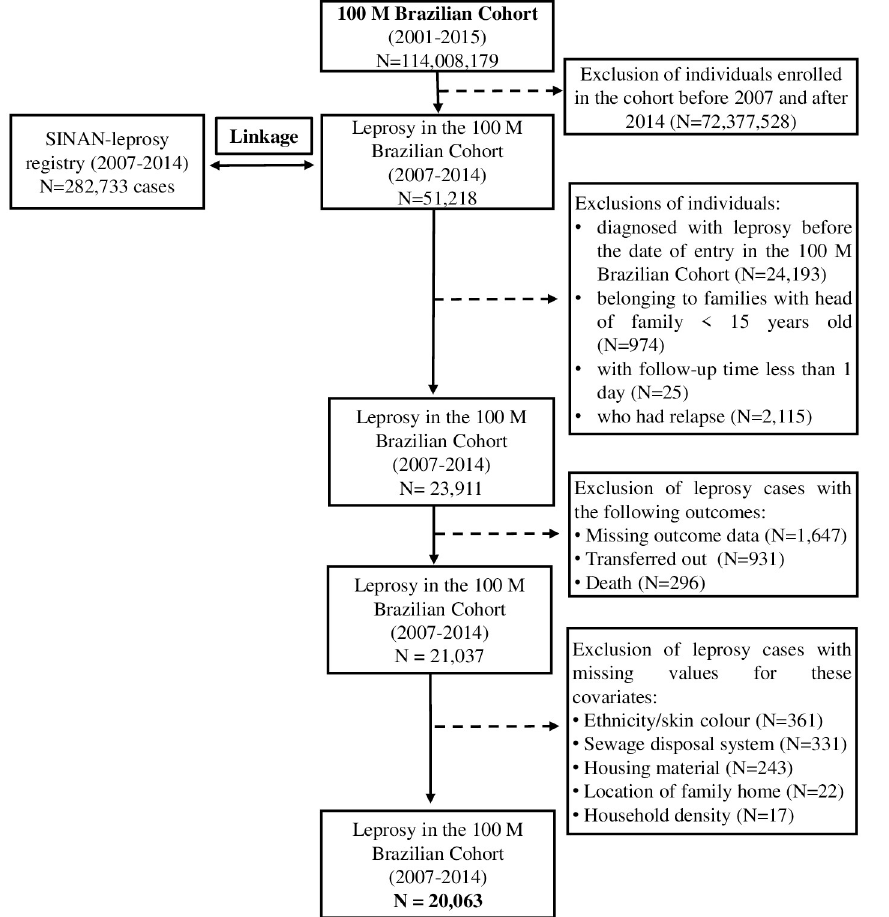
Fig 1. Study population selection flowchart from the 100 Million Brazilian